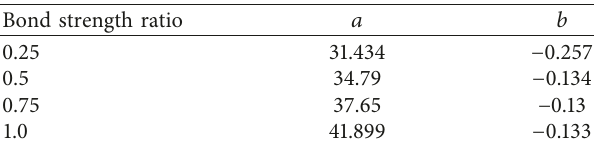
Table 2: Fitting parameters for peak dilation angle with different bond strength ratios.